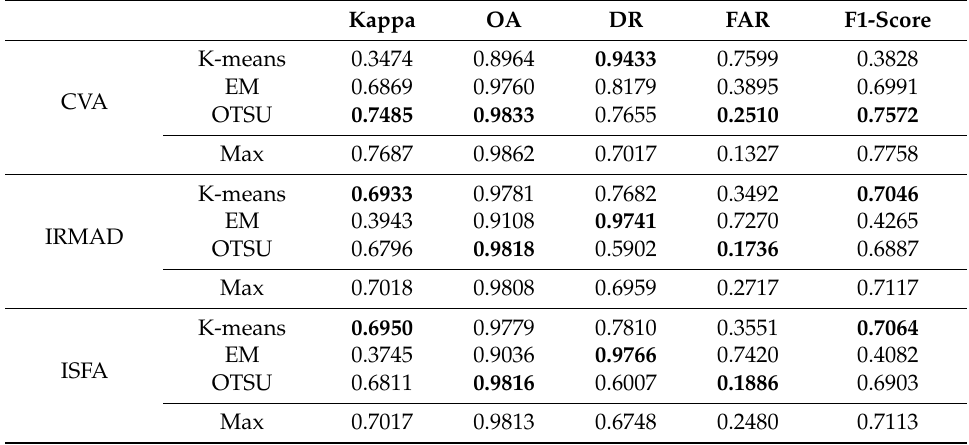
Table 3. Quantitative evaluation of different thresholding methods in test dataset 2.